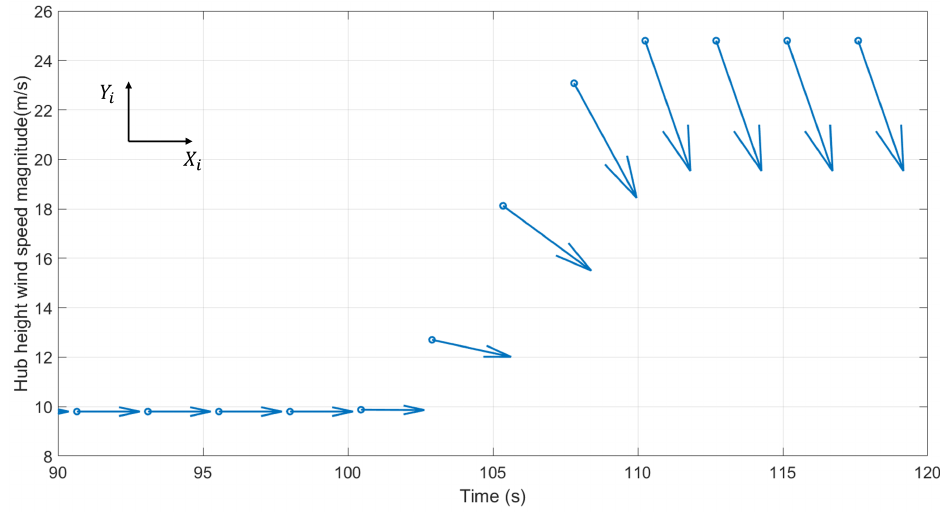
Figure 4. Wind speed vector plot.